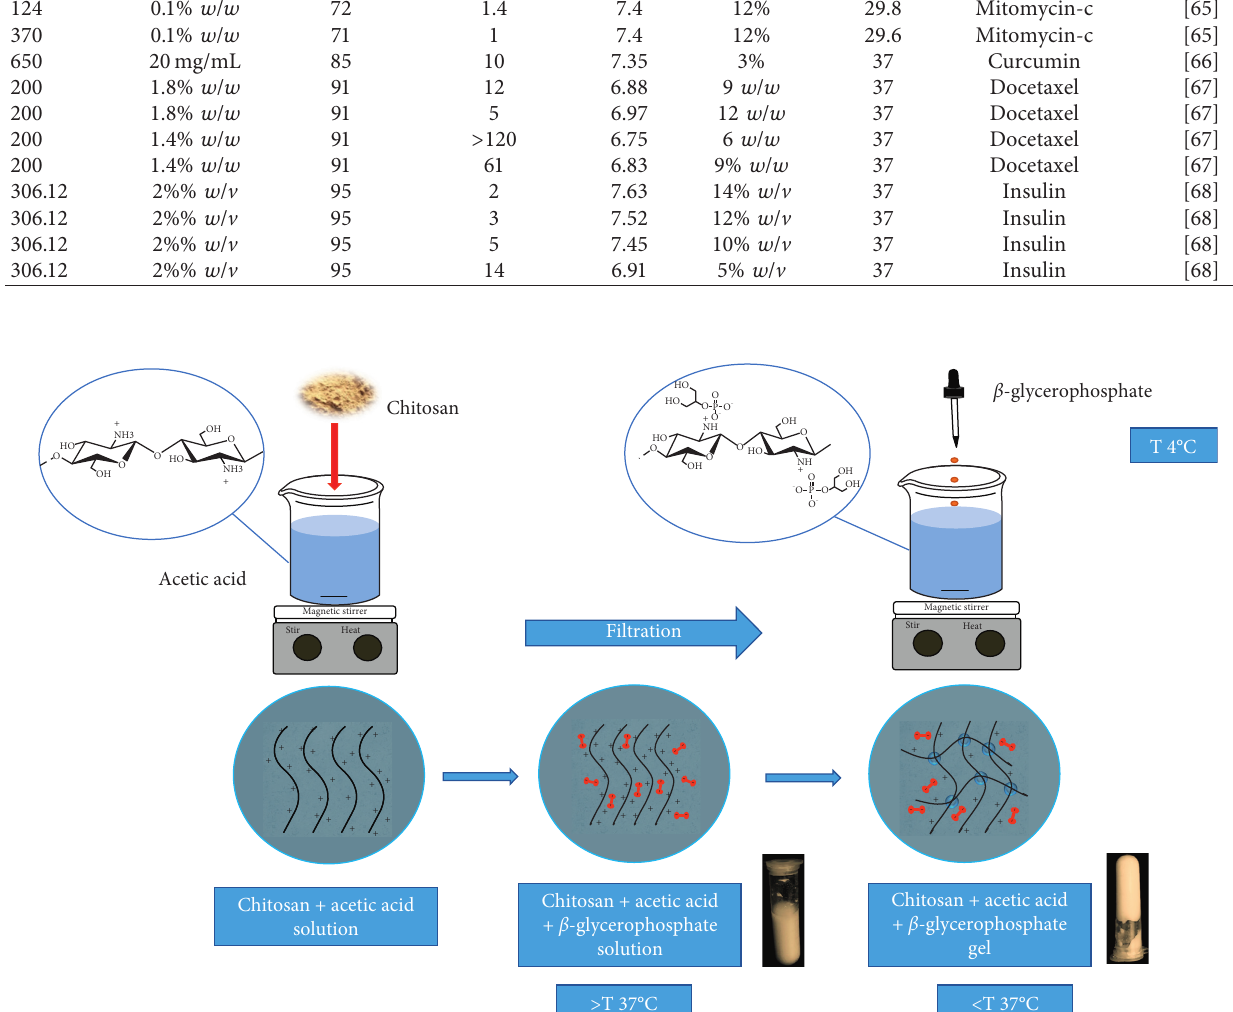
Figure 2: The schematic figure for preparing the chitosan-based